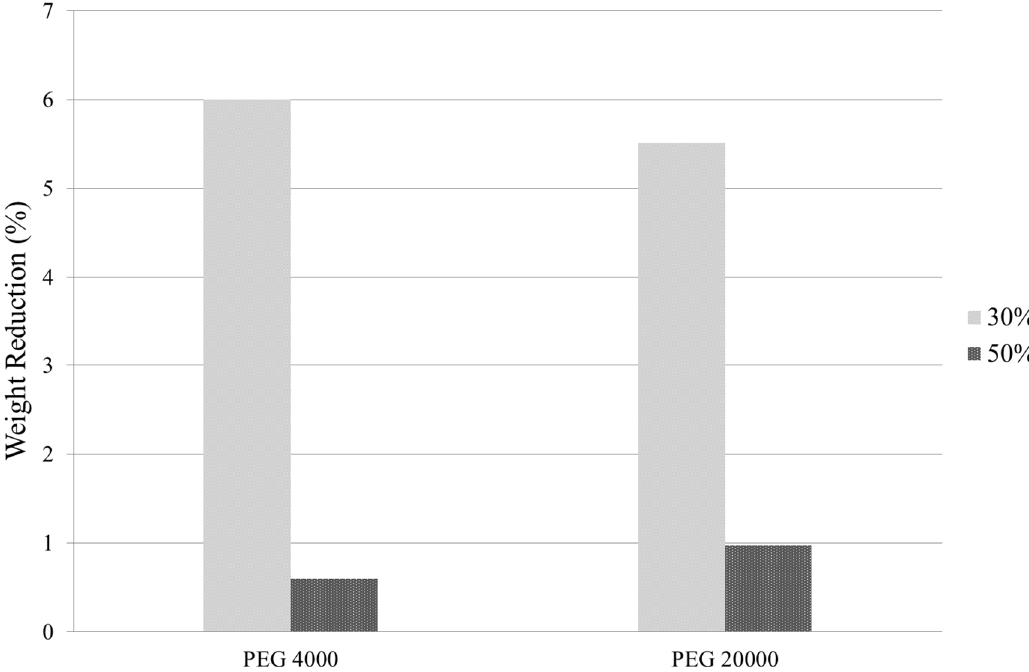
Figure 4. Sample weight reduction over the 20-h osmotic drying period using 30% and 50% conc. aqueous solution of PEG 4000 and PEG